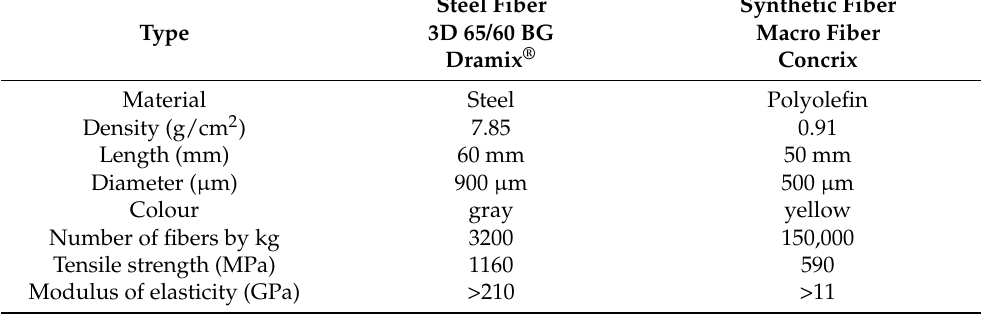
Table 2. The main properties of the used Steel and Synthetic (polypropylene) fibers.